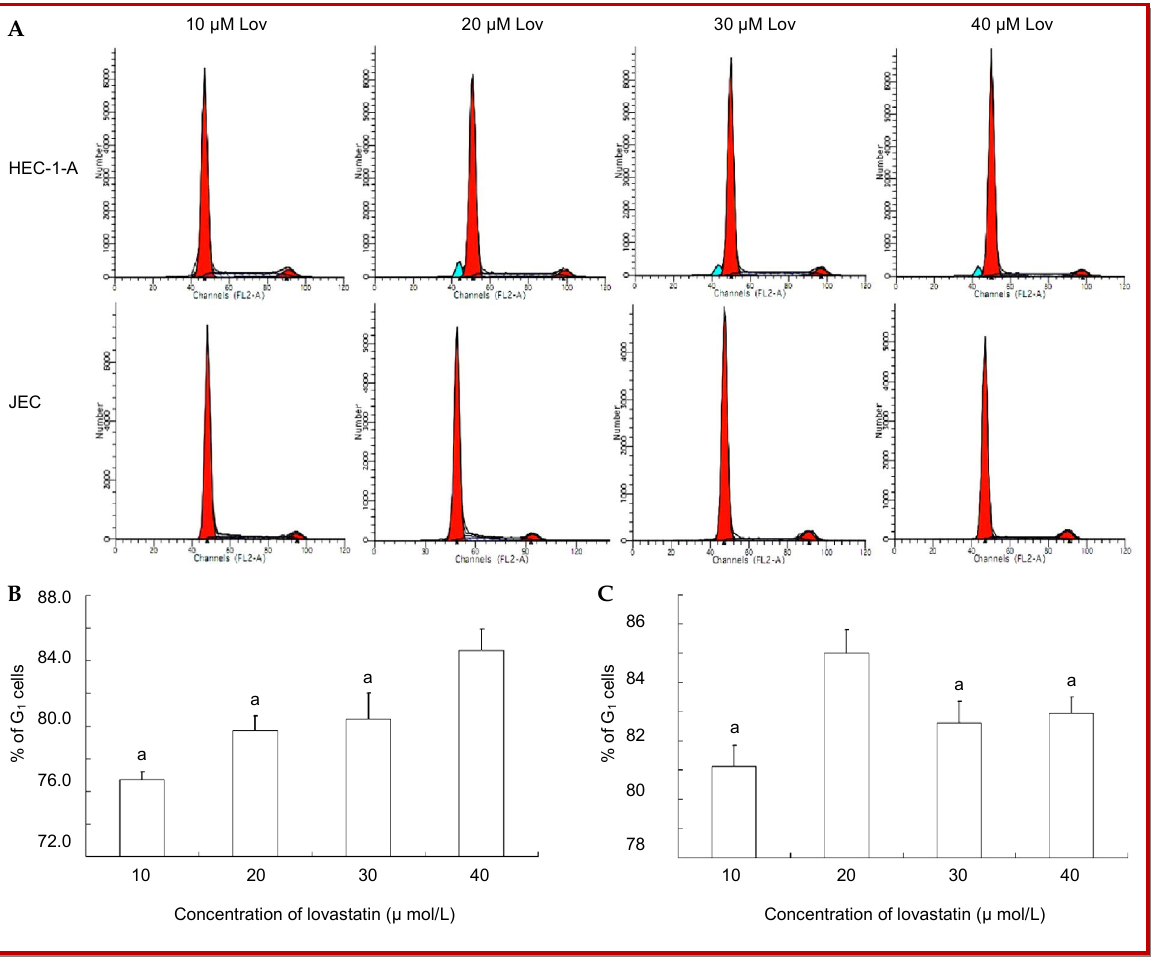
Figure 1: Optimal lovastatin concentration for G1-synchronization. (A) Flow cytometry of HEC-1-A cells and JEC cells following